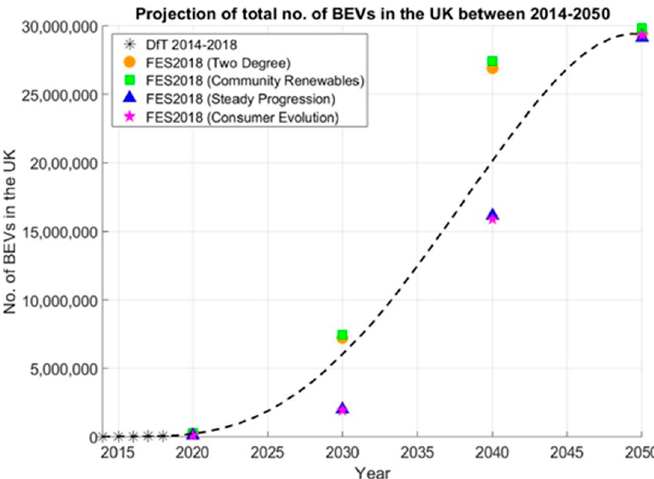
Figure 3. Predicted growth in battery electric vehicles (BEVs in the UK up to 2050 [5].